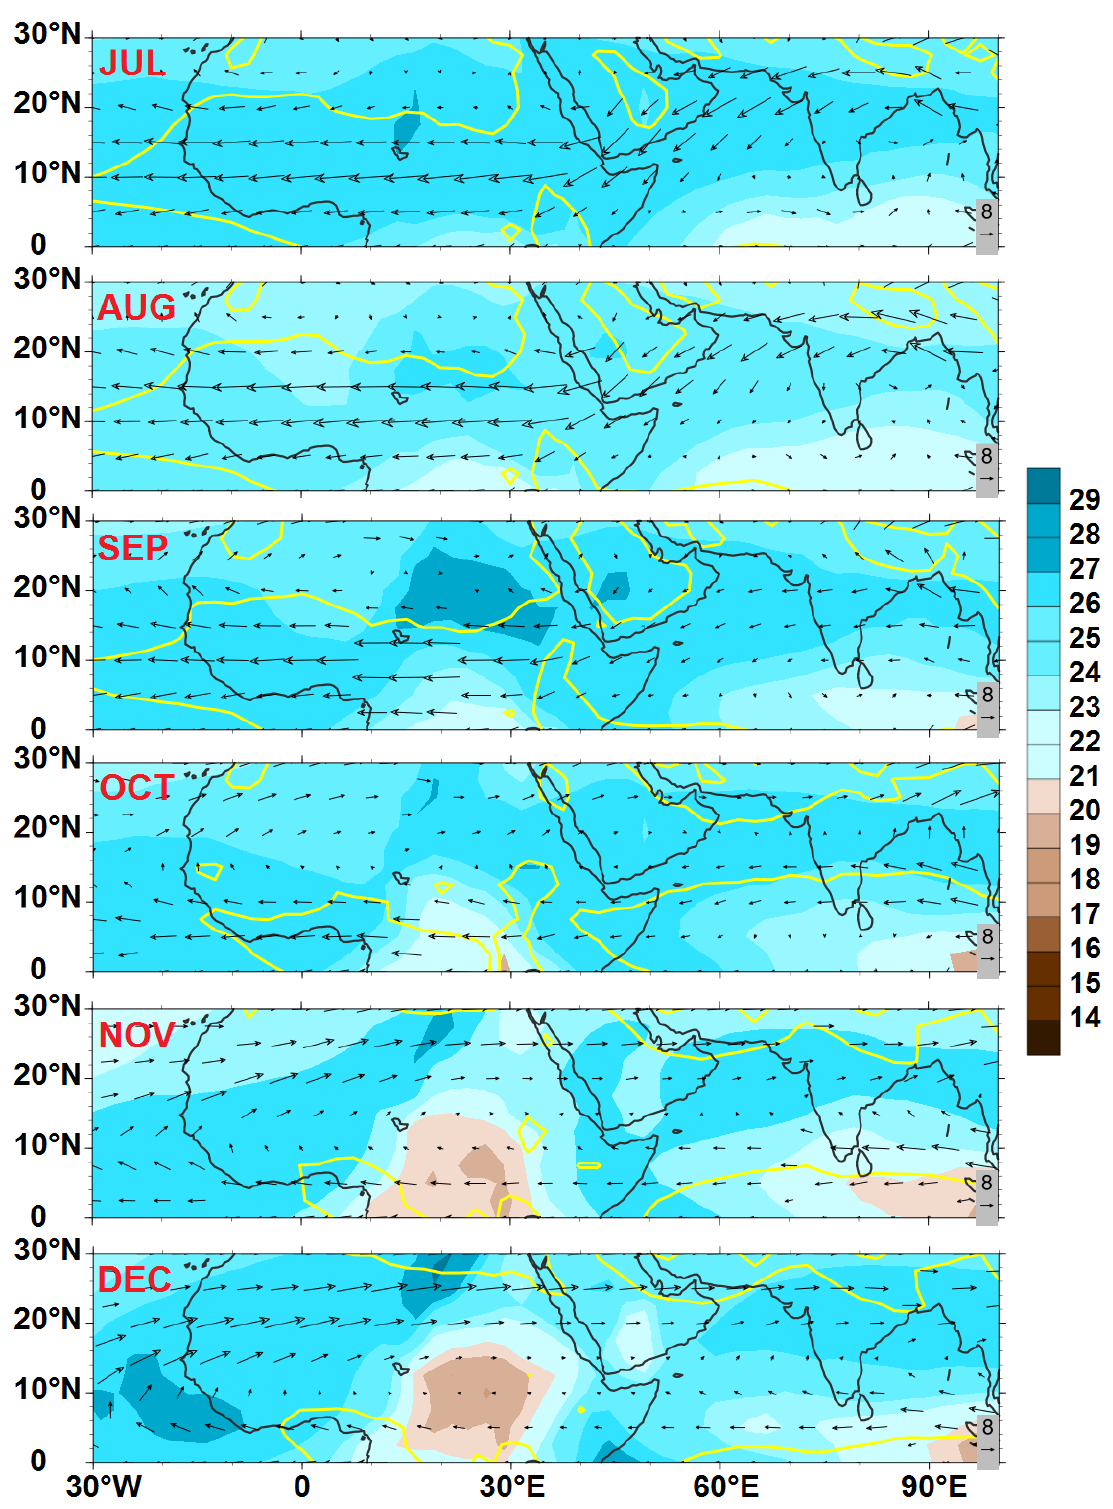
Figure 6. Monthly mean of OLR (colors, × 10 − 1 W · m − 2 ), horizontal moisture flux (vectors, kg · (m · s) –1 ), and zonal wind (yellow isoline 0 m · s –1 ) at 925 hPa over the period 1998–2008 from January to December.